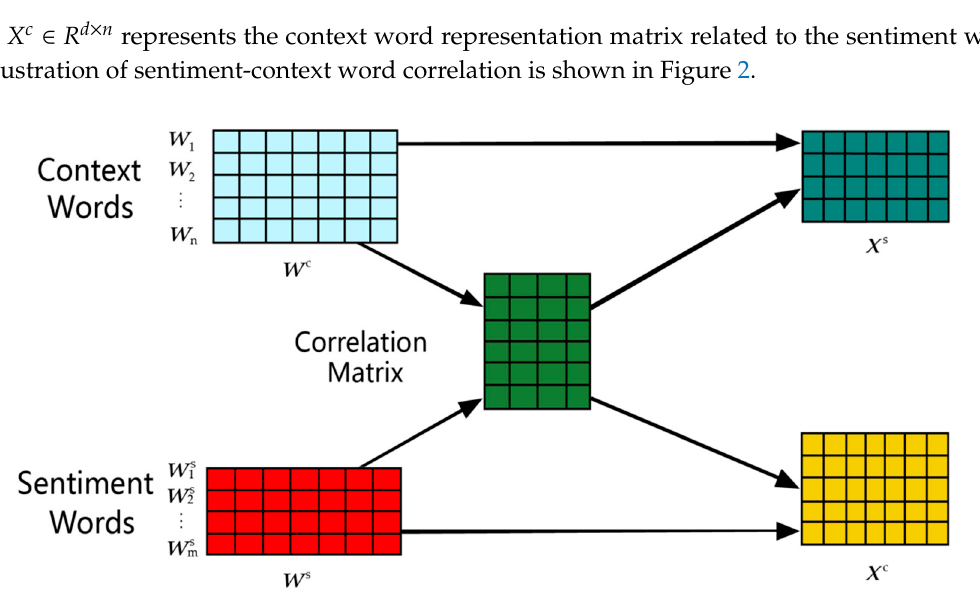
Figure 2. Sentiment-context word correlation.